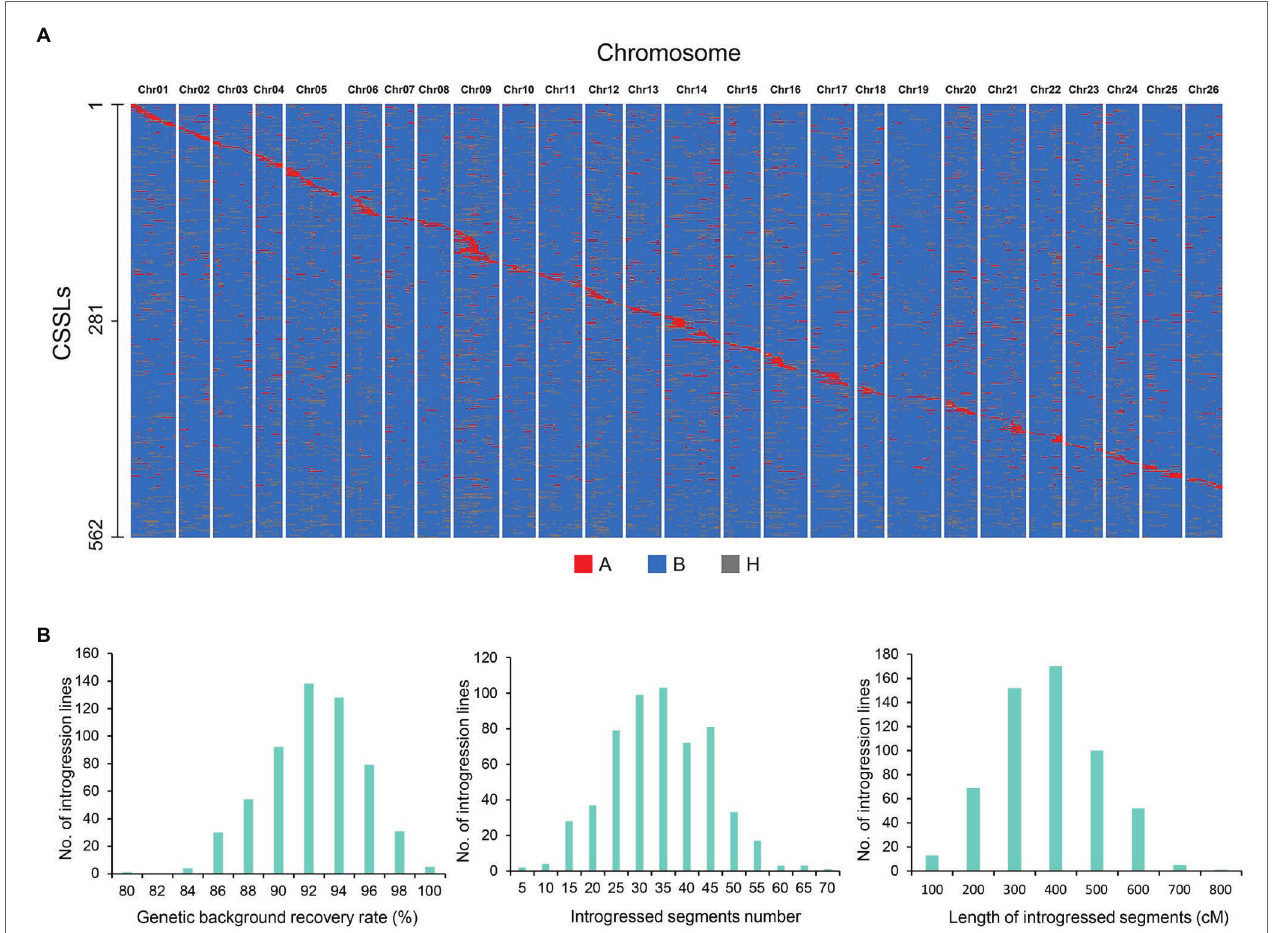
FIGURE 1 | Graphical representation of genotypes and chromosome introgressed segment calculations of the CSSLs population. (A) Distribution of introgressed segments in the CSSLs on the 26 chromosomes. A, Homozygous introgressed segments (donor parent Pima S-7); B, genetic background (recurrent parent CCRI35); H, heterozygous introgressed segments. (B) Genetic background recovery rate, number and length of introgressed segments in the CSSLs